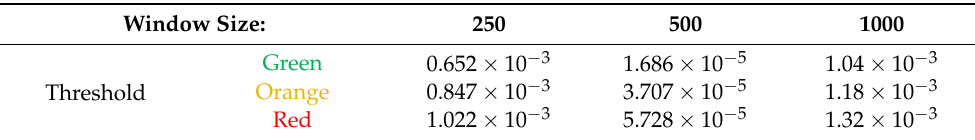
Table 1. The thresholds are based on a 99.95% and a 99.99% percentile of healthy training data, for Green and Red. The Orange threshold is the midpoint between the Green and Red thresholds.